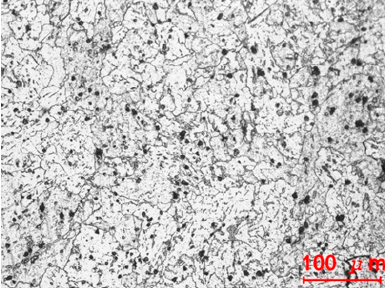
Figure 3. Microstructure of the fractured material.